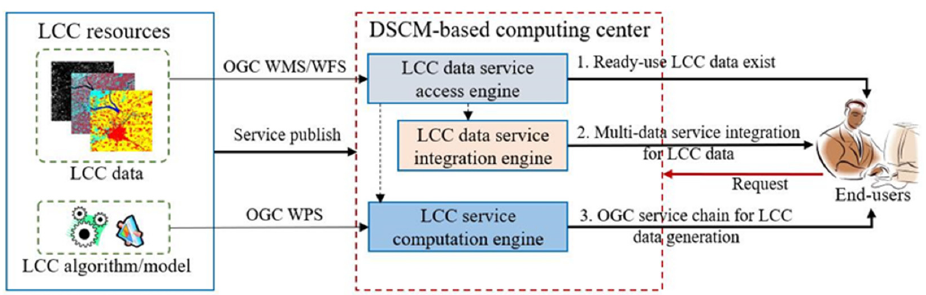
Figure 1. Monitoring the LCC by using a DSCM-based computing center .